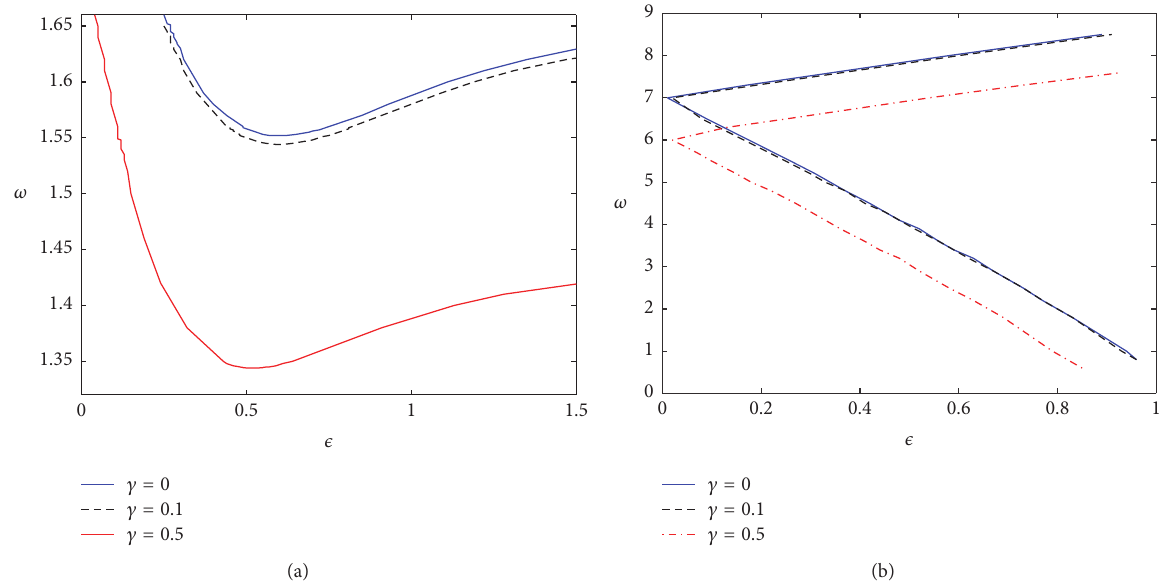
Figure 6: The stability region of the onsite soliton type I (a) and II (b) in the (𝜖, 𝜔) -plane for several values of 𝛾 . The solutions are unstable above the curves in panel (a) and between the curves in panel